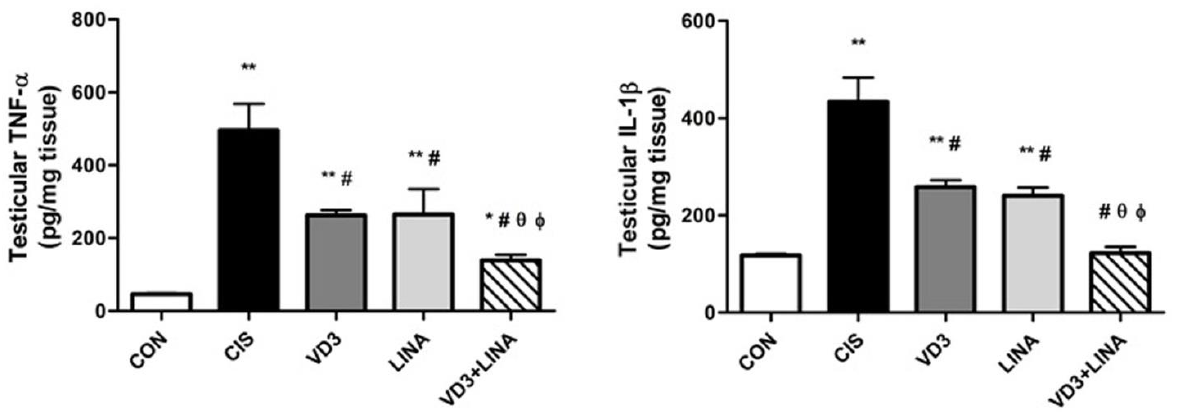
Figure 6. Effect of vitamin D3 and/or linagliptin on levels of inflammatory cytokines in testicular tissue of cisplatin-treated rats. Bars with error bars represent mean ± SEM ( n = 6/group); * p < 0.05, ** p < 0.001 vs. CON group; # p < 0.001 vs. CIS group; θ p < 0.01 vs. VD3 group; ϕ p < 0.01 vs. LINA group. TNF- α : Tumor necrosis factor-alpha; IL-1 β : Interleukin-1beta; CON group: control rats;